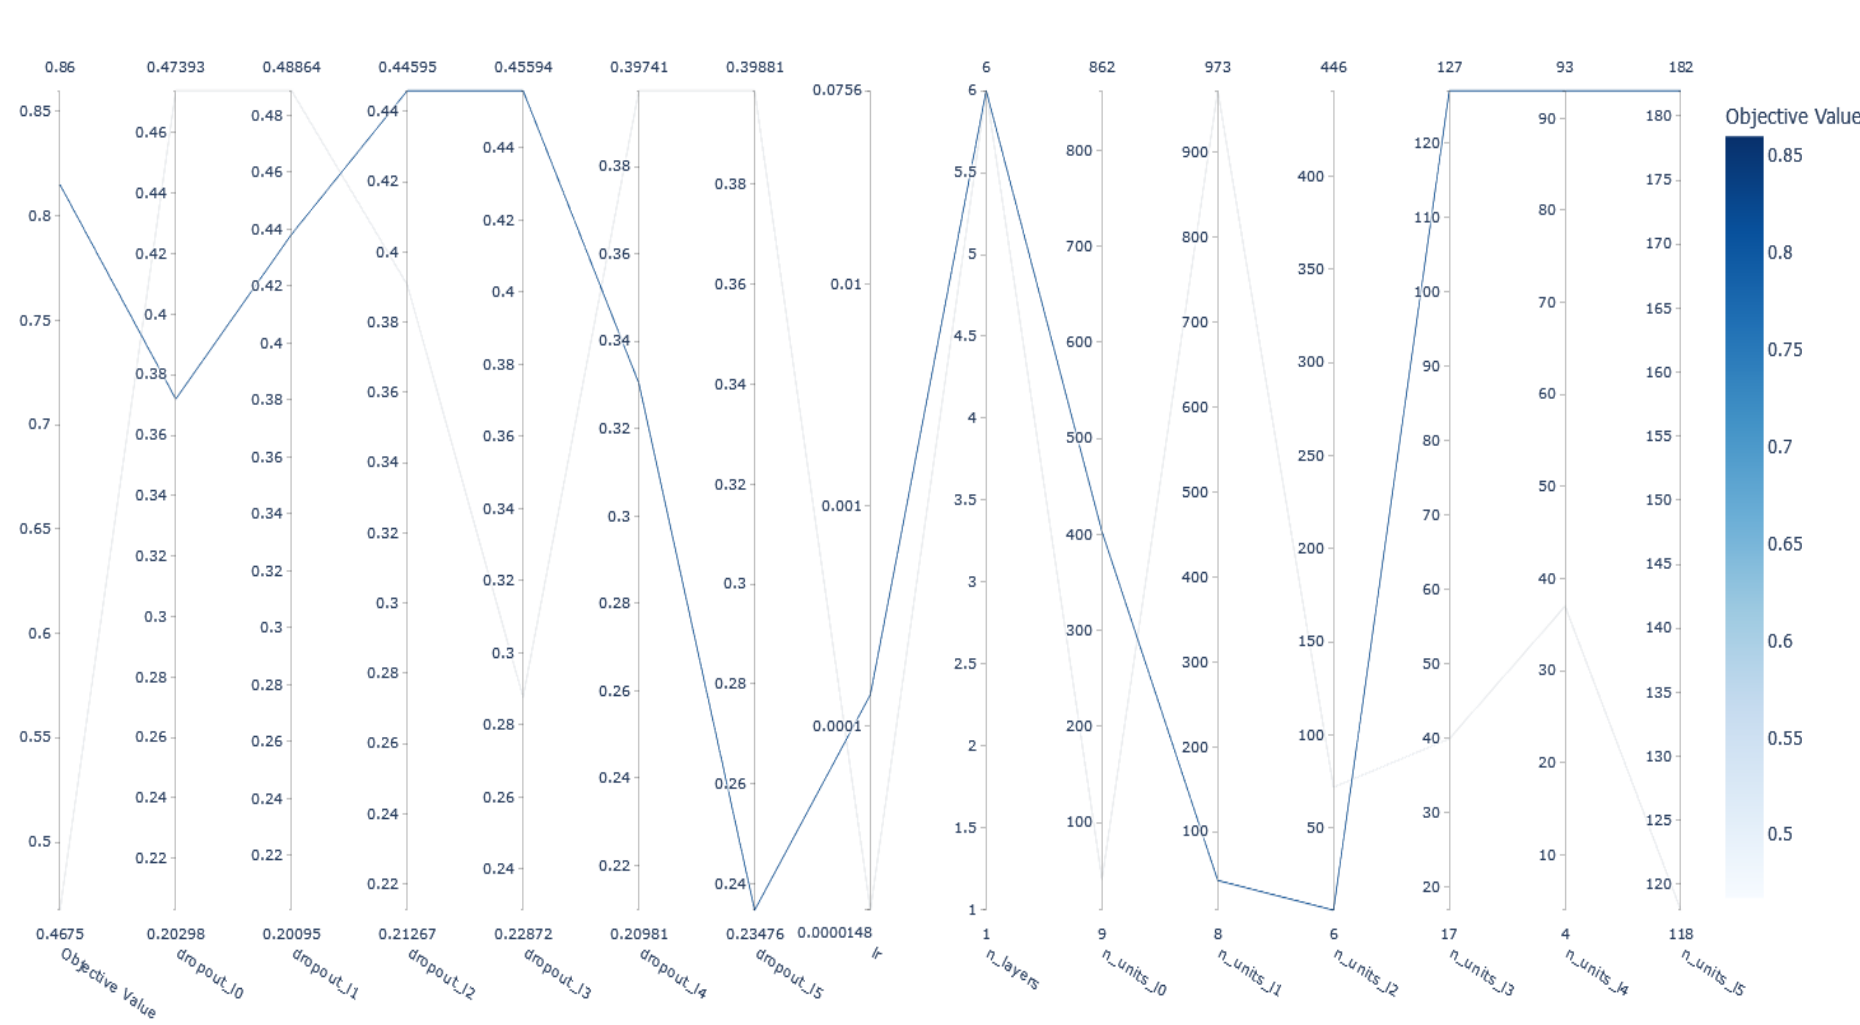
Figure 8. Hyperparameters’ parallel coordination schema of the DNN